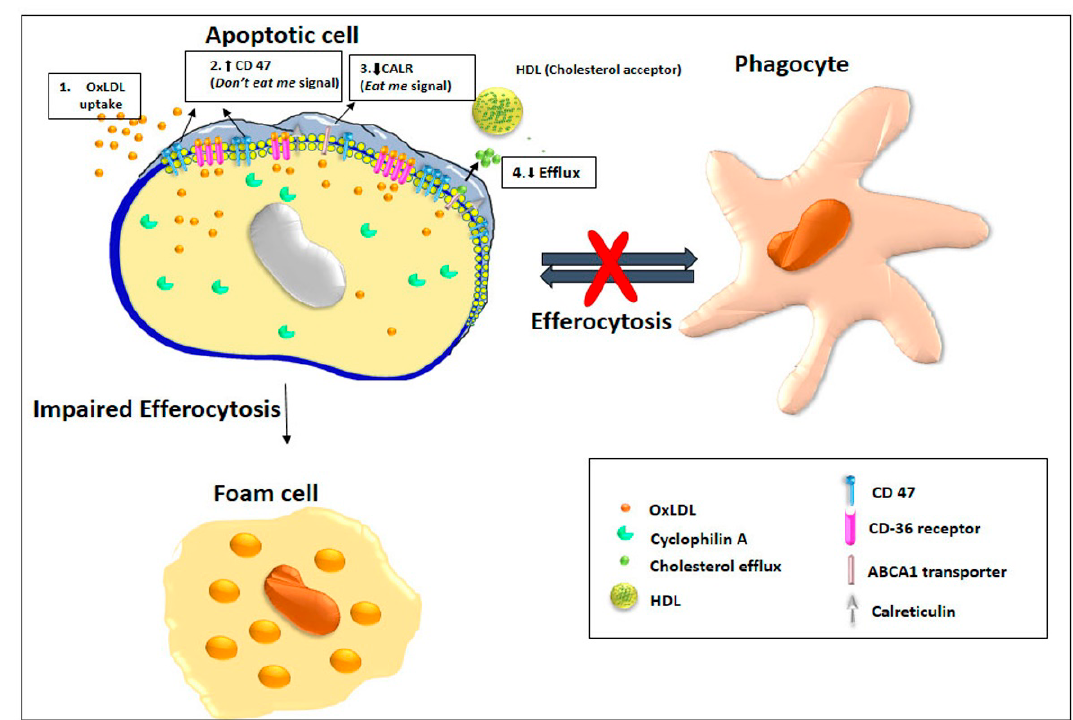
Figure 5. Cyclophilin A impairs efferocytosis by overexpressing don’t-eat-me signal, CD 47, and downregulating pro-apoptotic factor calreticulin. Cyclophilin A impairs efferocytosis and promotes atherosclerosis progression by (1) increasing OxLDL uptake through CD36, (2) reducing ABCA1-mediated reverse cholesterol efflux and (3) phagocyte survival by enhancing CD 47 expression (4) over calreticulin-mediated pathways and thereby stimulates fatty streak formation. Inefficient phagocytic clearance of apoptotic cells by lesional macrophages together with increased presence of apoptotic cells in the vascular lumen is the major reason for progression of fatty streaks to advanced atherosclerotic le- sions.